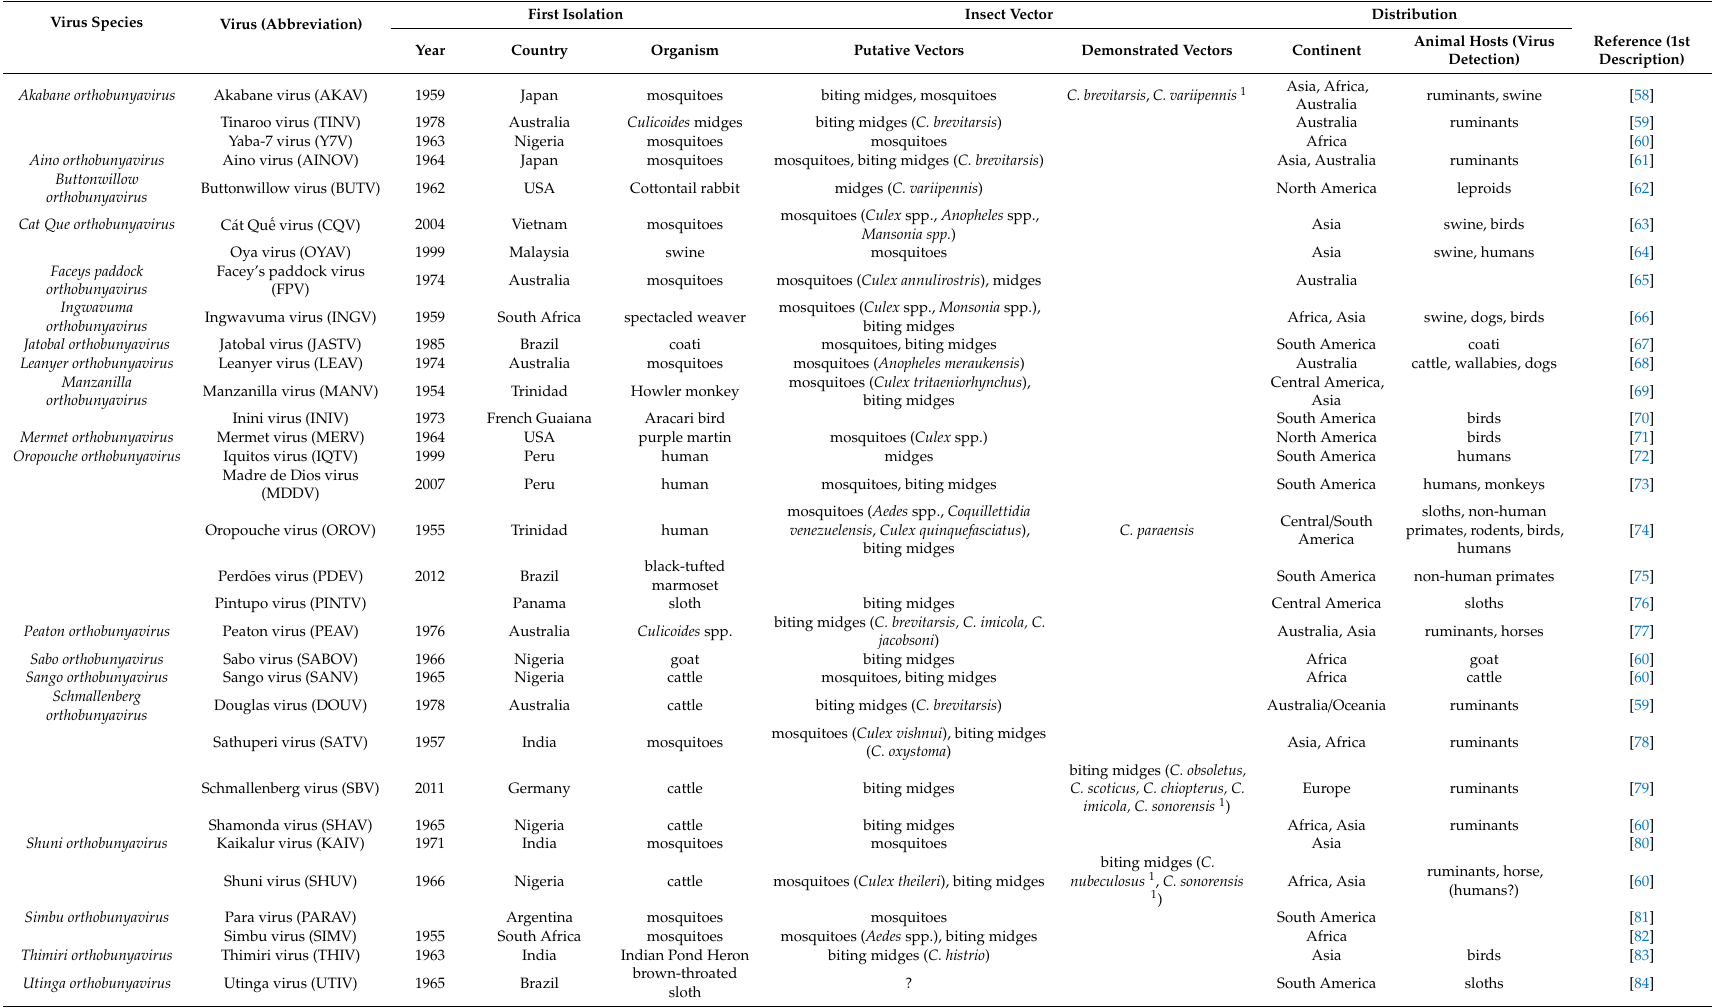
Table 1. Classification and distribution of Simbu serogroup viruses and vector species responsible for their